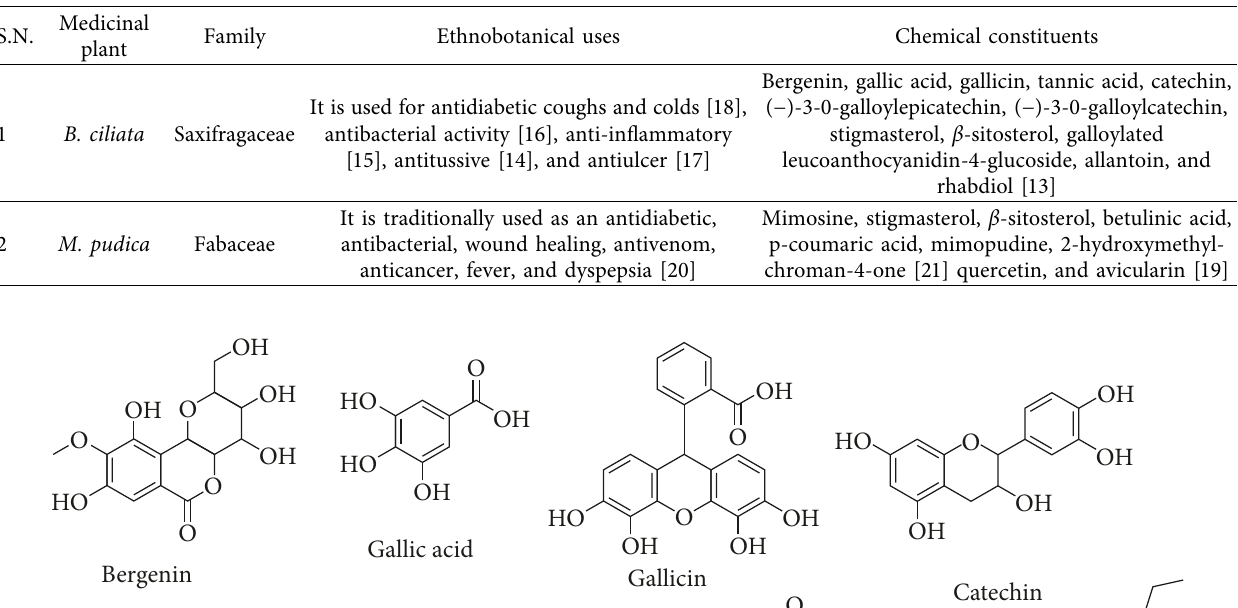
Table 1: Phytochemical constituents and the biological activities of B. Ciliata and M. pudica .